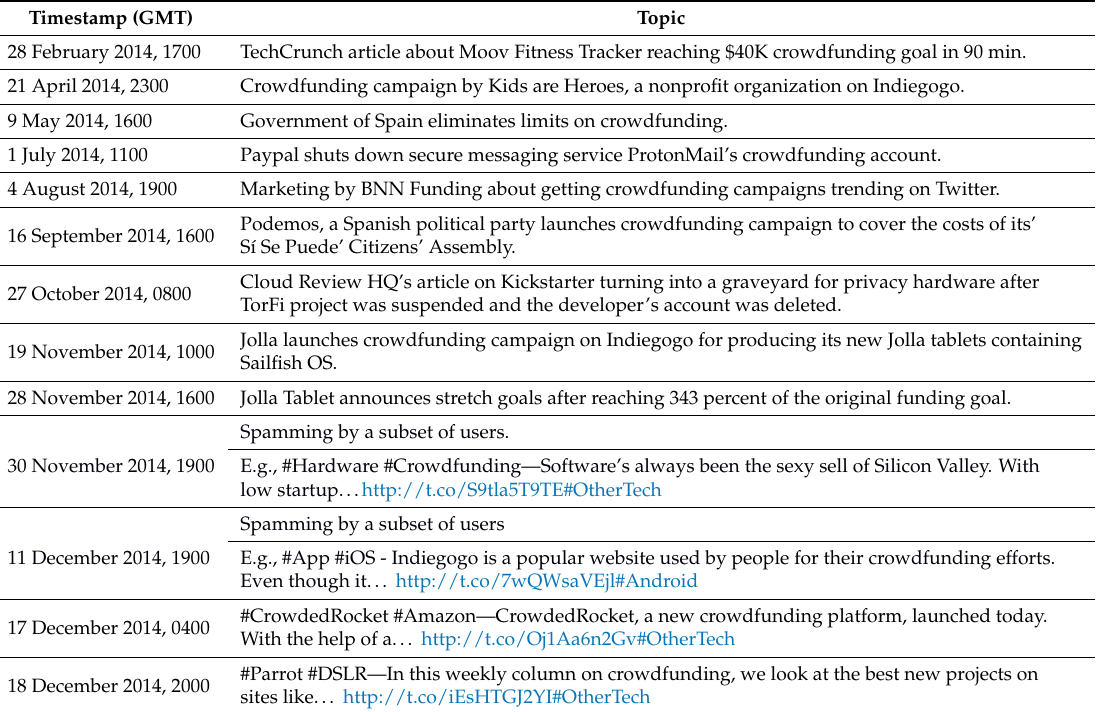
Table 8. Trending Topics Representing the